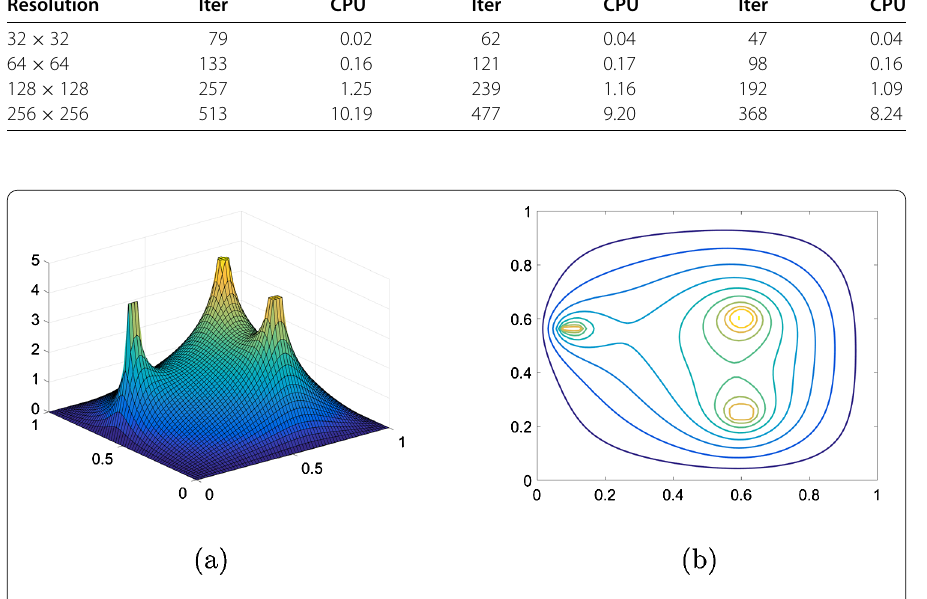
Figure 8 Nonlinear obstacle problem with ϕ = ϕ 1 at resolution 64 × 64. (a) The nonlinear numerical solution and (b) its contour plot.